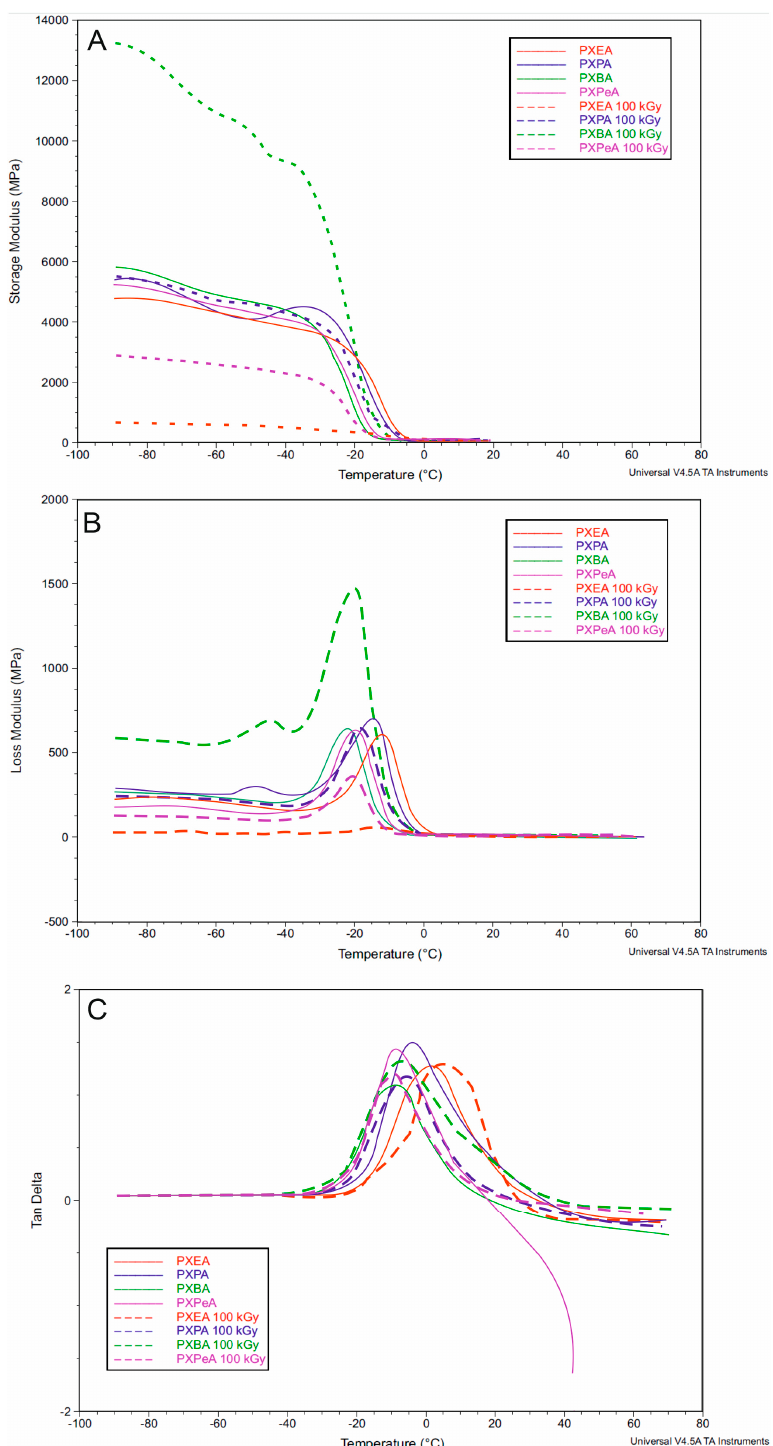
Figure 11. DMTA ( A ) Storage modulus (E’), ( B ) loss modulus (E’’), ( C ) loss tangent (tan delta versus temperature) for PXEA, PXPA, PXBA, and PXPeA.